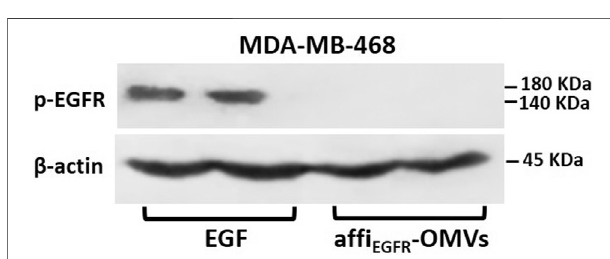
FIGURE 7 | EGFR activation in MDA-MB-468 cells. Overnight starved MDA-MB-468 cells were treated with af fi EGFR -OMVs (250 μ g/ml) or EGF (100 nM) for 30 min at 37 ° C prior to lysis. Cell lysates were subjected to Westernblottinganalysis.RepresentativeWesternblotbandsforp-EGFR and β -actin are shown along with two replicate bands for the af fi EGFR -OMVs andEGFtreatments. β -Actinbandsarepresentedasacontroloftheloading amount of